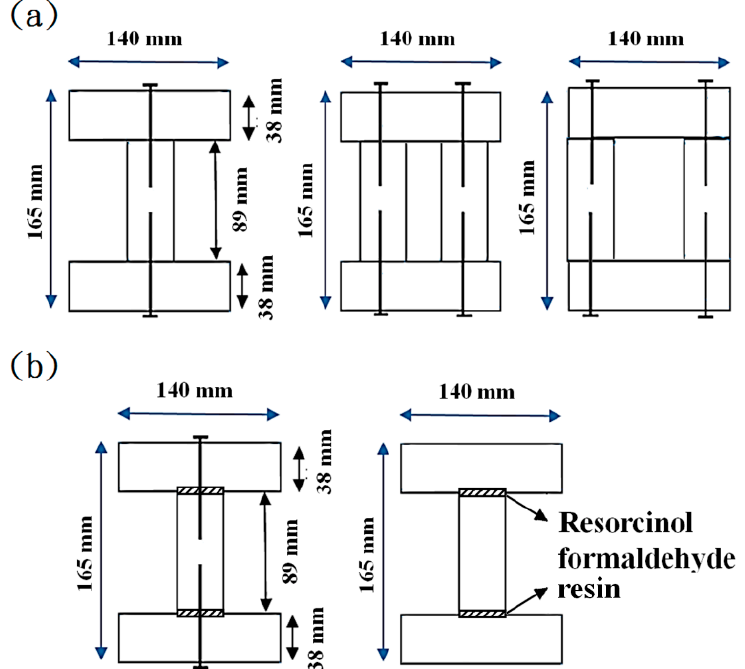
Figure 2. Cross-sectional shapes of built-up beams using ( a ) self-tapping screws and ( b ) glue and screws.